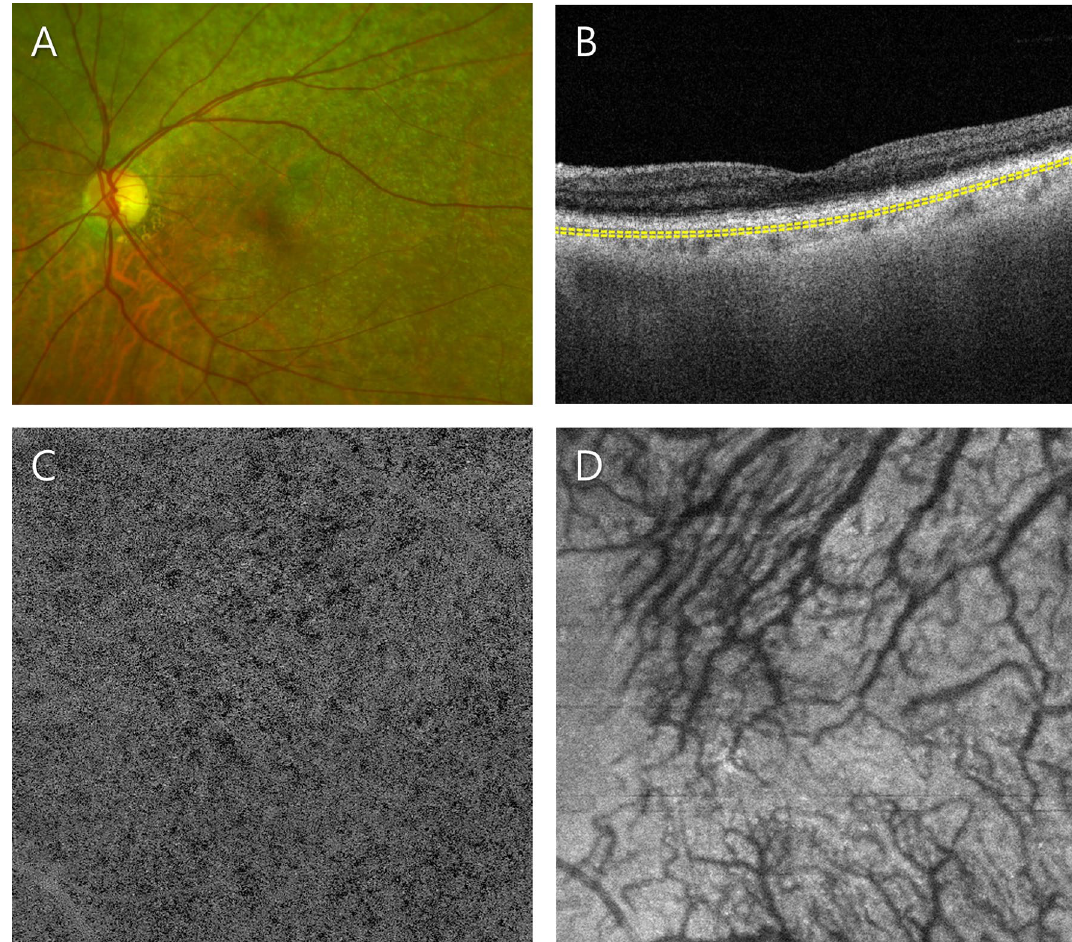
Figure 3. Representative patient in the soft drusen plus subretinal drusenoid deposit (SDD) group. ( A ) Ultra- widefield fundus photograph showing drusen mixed with dispersed SDD at the posterior pole. ( B ) Optical coherence tomography (OCT) B-scan image showing the mixed form of drusen and SDD. The subfoveal choroidal thickness was 153 µm. Slab to acquire the choriocapillaris (CC) layer is depicted as a yellow dashed line. ( C ) OCT angiography (OCTA) image of the CC. Enlarged flow voids were distributed heterogeneously throughout the scanned area. The average size, number and total area of flow voids were 684.6 µm 2 , 17,360, and 11.9 mm 2 , respectively. ( D ) Structural en face OCT image of the Haller layer. The mean and standard deviation of the Haller vessel diameter were 86.8 and 38.8 µm,